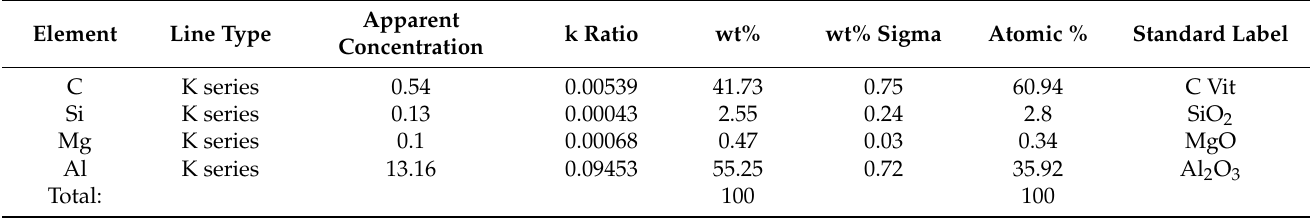
Table 6. The composition percentage of NZ and TMAZ obtained from the FSSW process was measured via EDX mapping.